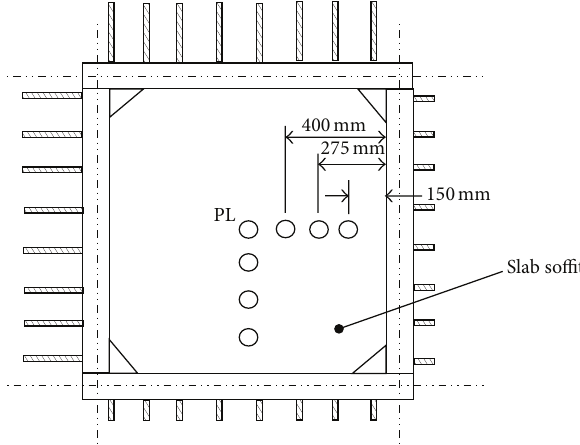
Figure 8: LVDT arrangements on the soffit of all slabs.